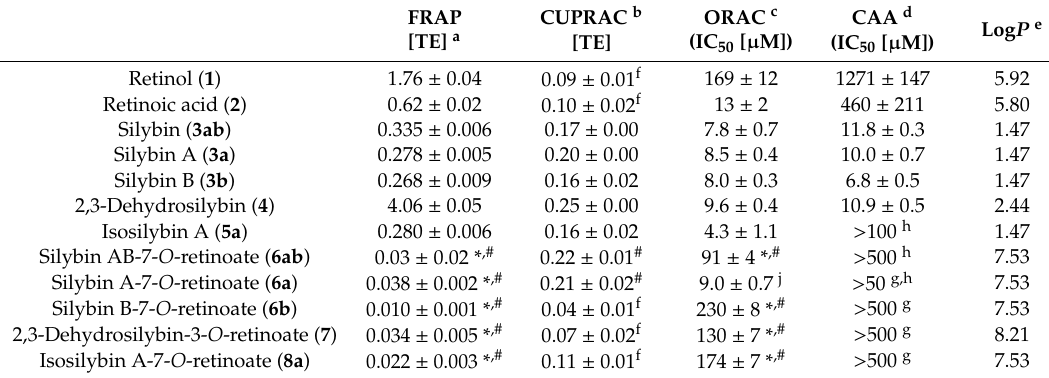
Table 2. Antioxidant activities and lipophilicity / hydrophilicity of retinoic conjugates in comparison with their parent